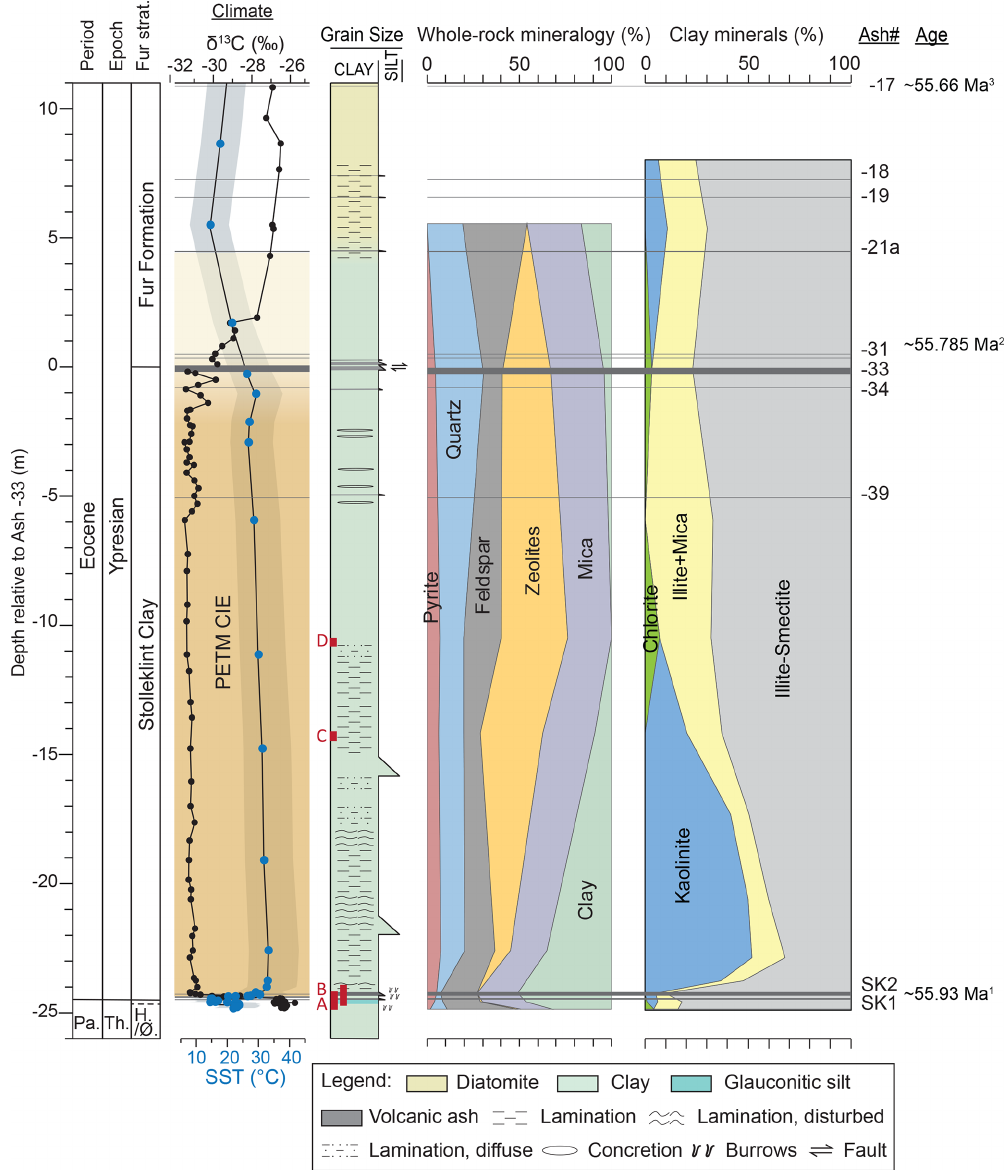
Figure 4. The studied stratigraphy from the island of Fur shown on the left with the depth scale measured upwards and downwards from the main marker bed Ash − 33. Strat.: stratigraphy; Pa.: Paleocene; Th.: Thanetian; H./Ø.: Holmehus/Østerrende Formation (dotted line indicate base of the glauconitic silt). Overall climate indicated is based on previously published data from the study area. The yellow column indicates the interpreted PETM CIE duration, based on the δ 13 C curve from Jones et al. (2019). The base of the column marks the CIE onset, and the gradually lighter colours toward the top mark the CIE recovery. Sea surface temperature (SST) variations are given as BAYSPAR (Tierney and Tingley, 2014)-calibrated TEX 86 SSTs with 1 σ error bar indicated by the light blue area (Stokke et al., 2020a). Sedimentological log from Stolleklint with legend below. Red squares labelled A–D indicate the stratigraphic position of XRF box-core scans shown in Figs. 5 and 6. Bulk rock mineralogy and clay fraction mineralogy ( < 2µm) is presented as percentages. Note that the clay fraction represents separate analyses with a much lower detection limit than the bulk analyses, and therefore does not directly reflect the results of the bulk mineralogy. Ages indicated on the right are based on the following sources, indicated by superscript numbers: 1 – estimated age for PETM onset from Westerhold et al. (2018); 2 – age of bentonite from Charles et al. (2011) marking the middle of the PETM recovery assuming the Svalbard and Fur CIEs timing is coeval; 3 – corrected Ar–Ar age of Ash − 17 from Storey et al. (2007a) recalibrated to the Fish Canyon Tuff (FCT) calibration from Renne et al. (2010, 2011) to 55.66 ± 0.12Ma.